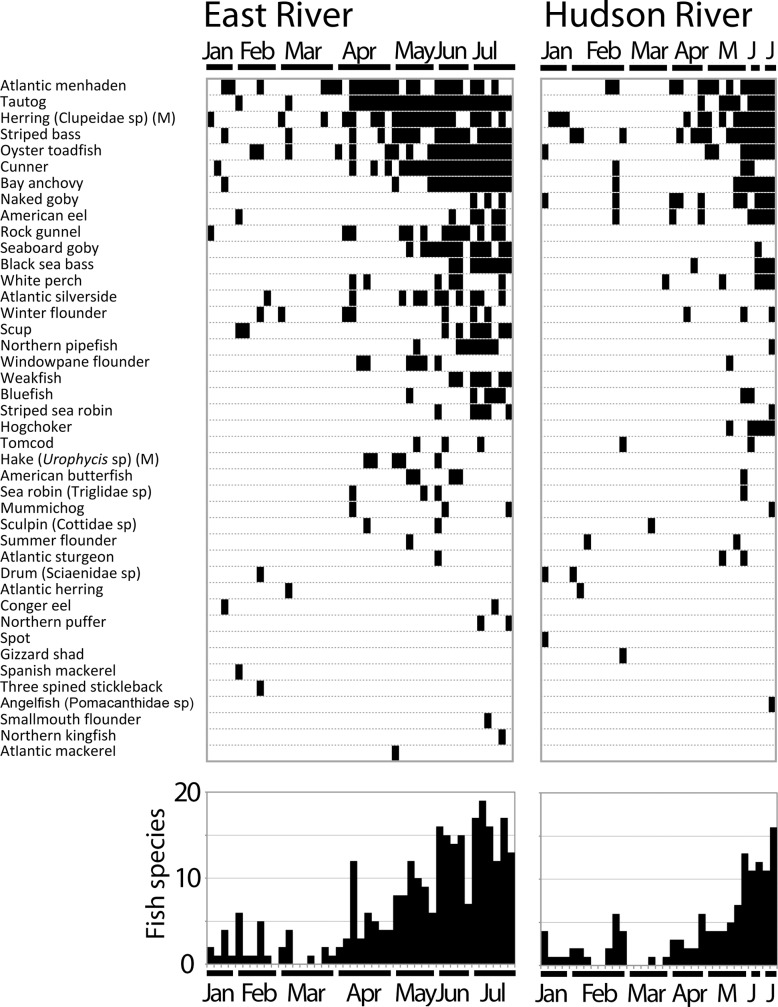
Local marine fish eDNA presence and absence by date and site.Top: black indicates eDNA presence; each column represents an individual sample, arranged by collection date, with collection site and month shown; each row represents a unique amplified fish sequence with identification at left, arranged by decreasing frequency of detection and number of reads. (M) indicates matching multiple local species; incomplete identifications are shown with genus or family names. Collection dates, scientific names, and identification details are in S3 and S4 Tables. Bottom: number of fish species detected per sample.